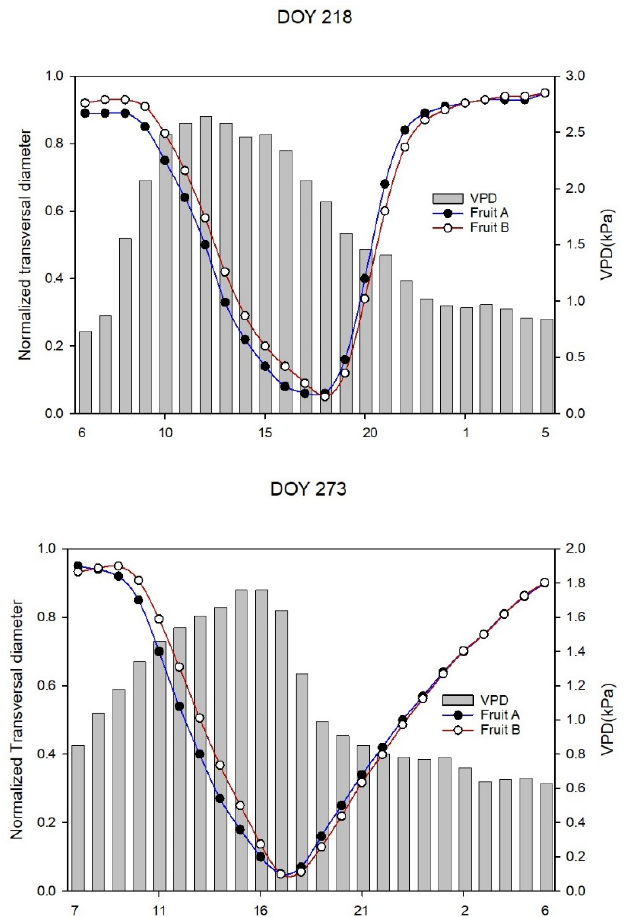
Figure 3. Continuous measurements of transversal diameter of fruit A and fruit B at selected days during the first period of the experiment.